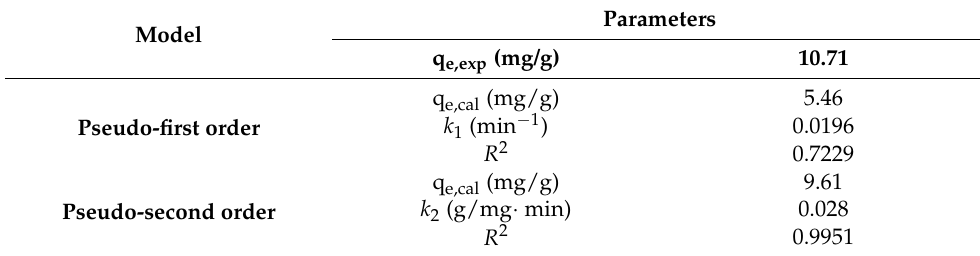
Table 3. Pseudo-first-order and second-order